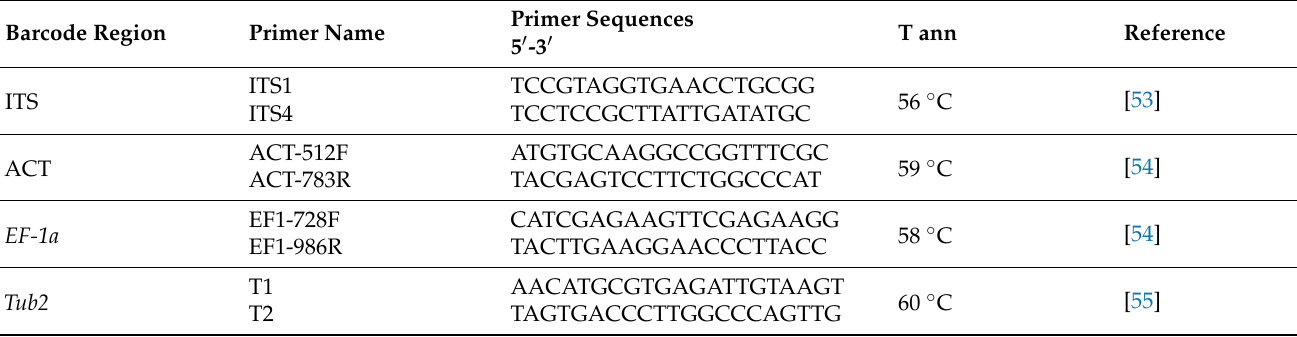
Table 2. Primer sequences for barcode loci amplified in this